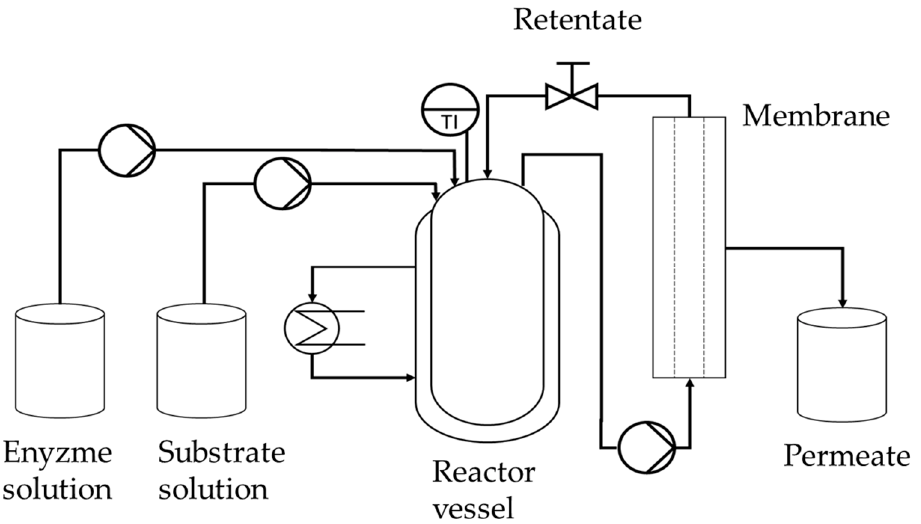
Figure 1. Process scheme for continuous fructo-oligosaccharide (FOS) production containing the enzyme and substrate feed tanks, the reactor vessel, the membrane module, and the permeate tank.